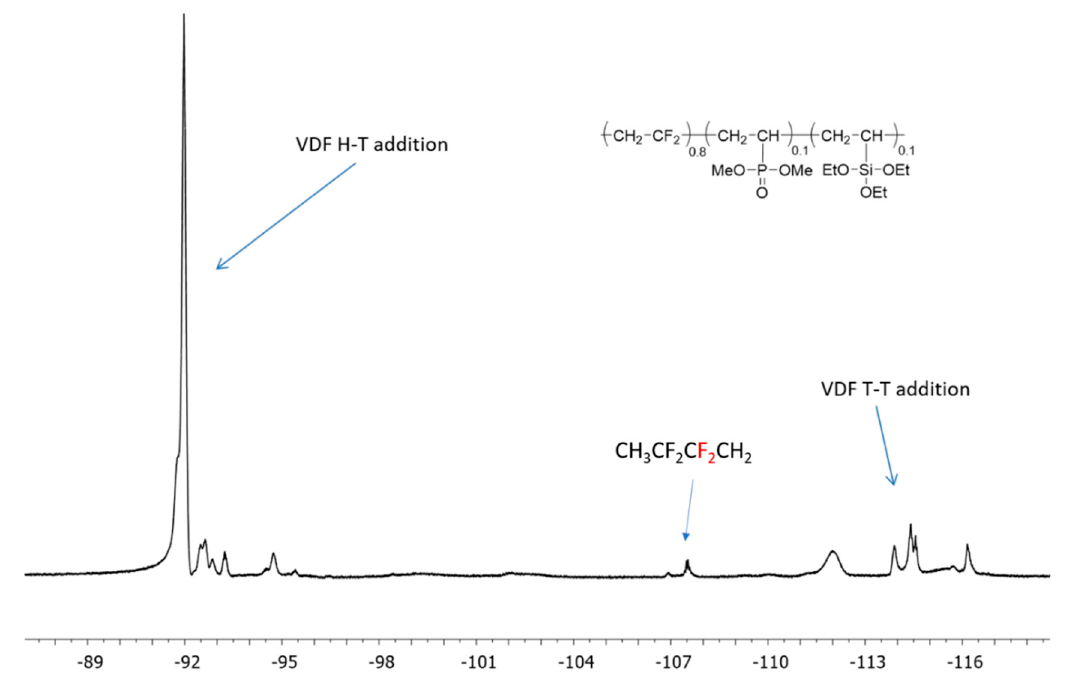
Figure 2. 19 F NMR spectrum of poly(VDF- ter -VTEOS- ter -VDMP) terpolymer ( P 20 , Table 1), recorded in DMF- d 7 at 20 °C.